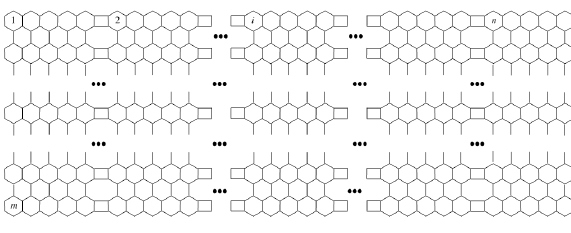
Figure 4: Multiple Pentacene.